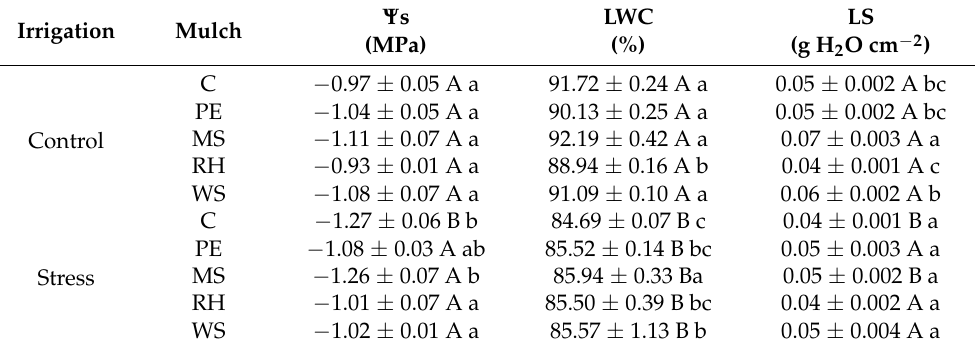
Figure 1. ( a ) Shoot FW, ( b ) root FW, ( c ) total FW, and ( d ) leaf area of escarole plants of the commercial variety “Brillantes” non-mulched or subjected to different mulching treatments and cultivated under control (well-watered) and water stress (70% ETc) conditions. Bars show the means of five plants ± standard error. Different capital letters indicate significant differences due to the water stress treatment while different small letters show significant differences among mulching treatments according to Tukey’s test ( p ≤ 0.05). Abbreviations used: non-covered substrate (C), polyethylene mulch (PE), mushroom substrate-based hydromulch (MS), rice hulls-based hydromulch (RH), and wheat straw-based hydromulch (WS). Table 1. Osmotic potential ( Ψ s), leaf water content (LWC), and leaf succulence (LS) of escarole plants of the commercial variety “Brillantes” non-mulched or subjected to different mulching treatments and cultivated under control (well-watered) and water stress (70% ETc)